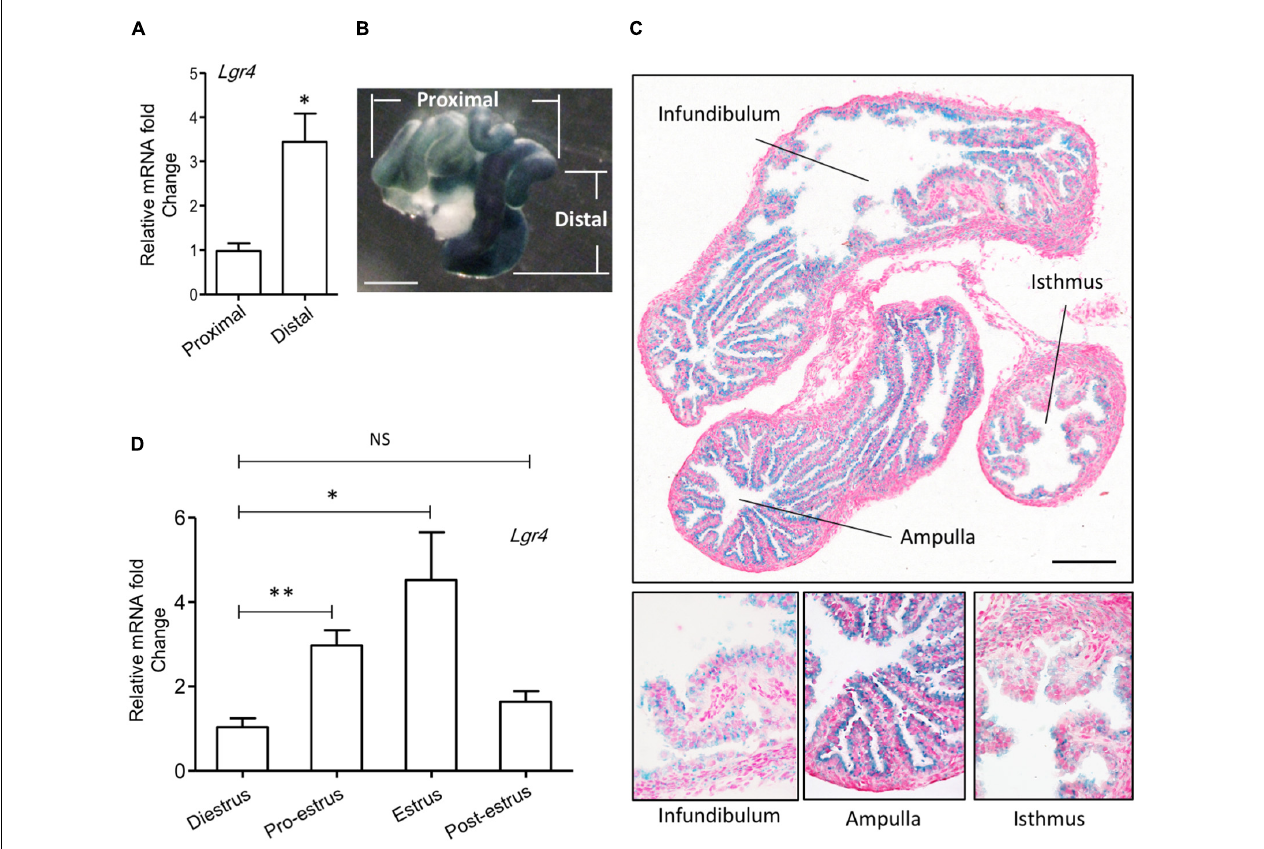
FIGURE 1 | Expression of Lgr4 in oviducts of mice. (A) The relative expression of Lgr4 mRNA in the specific regions of the oviduct of the WT mice. (B) A whole mount LacZ staining represented the spatial expression pattern of Lgr4 in a heterozygous mouse oviduct. (C) A LacZ staining of a cryo-section of an Lgr4 heterozygous mouse oviduct. (D) The relative expression of Lgr4 mRNA in the mouse oviduct at different stages of the estrus cycle. At least three independent experiments were carried out. Data are presented as mean ± SEM of three mice. ∗ p ≤ 0.05; ∗∗ p ≤ 0.01. Scale bar, 1,000 µ m in (B) ; 200 µ m in (C)